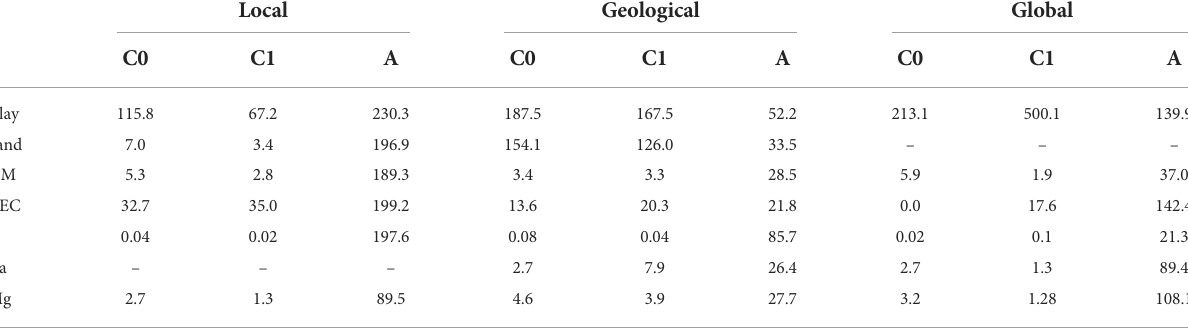
TABLE 3 Parameters of fi tted variograms for clay, sand, organic matter (OM), cation exchange capacity (CEC), potassium (K), calcium (Ca), and magnesium (Mg) predicted values using online spectra of experimental fi eld from three different calibration strategies of only in- fi eld samples (local), adding samples from the same geological region (geological), and from different geological regions (global). Local